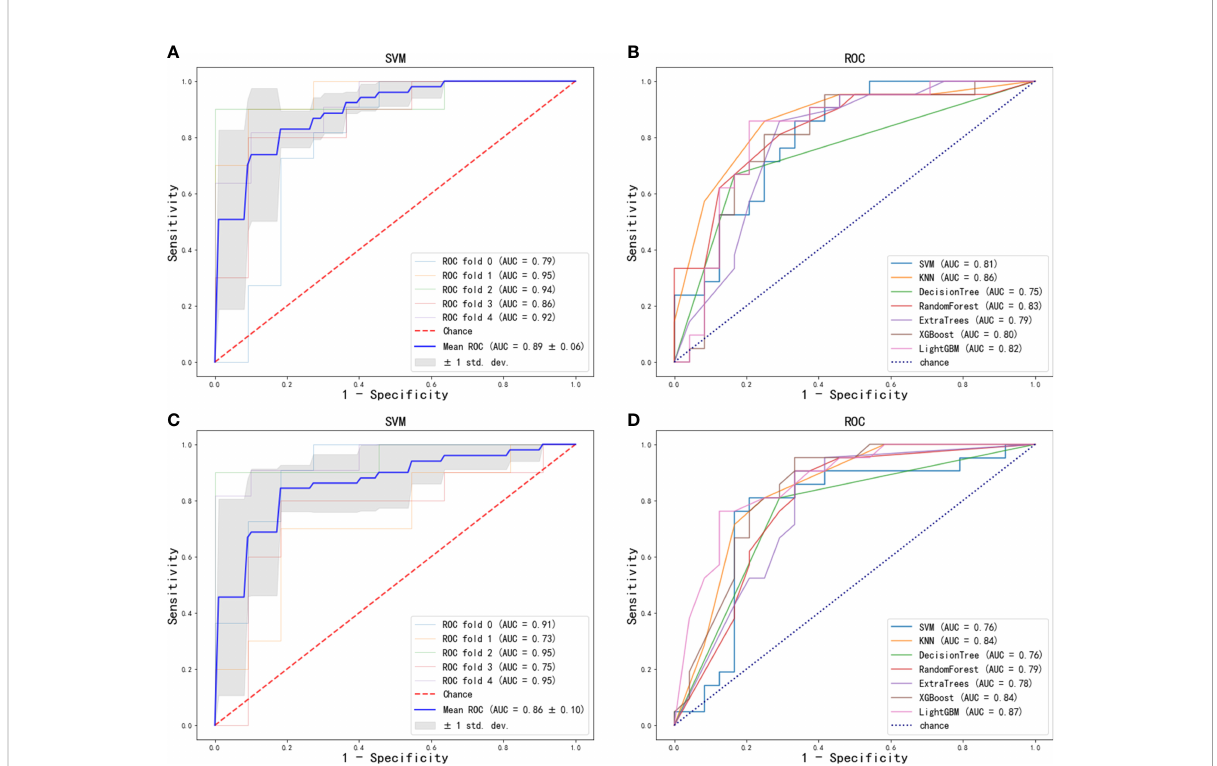
FIGURE 3 ROC curve of radiomics features for the prediction of ALN metastasis: (A) optimal model (SVM) in training cohort; (B) seven machine learning models in test cohort. ROC curve of deep-learning features for the prediction of ALN metastasis: (C) optimal model (SVM) in training cohort; (D) seven machine learning models in test